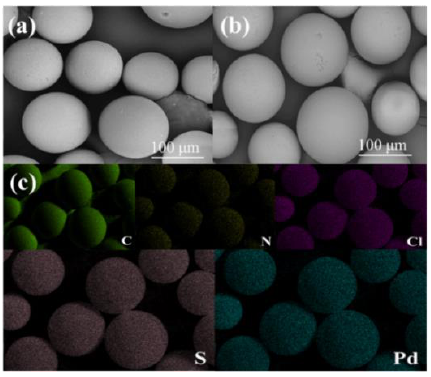
Figure 4. ( a ) SEM image of PS-DMTD, ( b ) PS-DMTD-Pd (II), and ( c ) the elemental mapping images of PS-DMTD-Pd